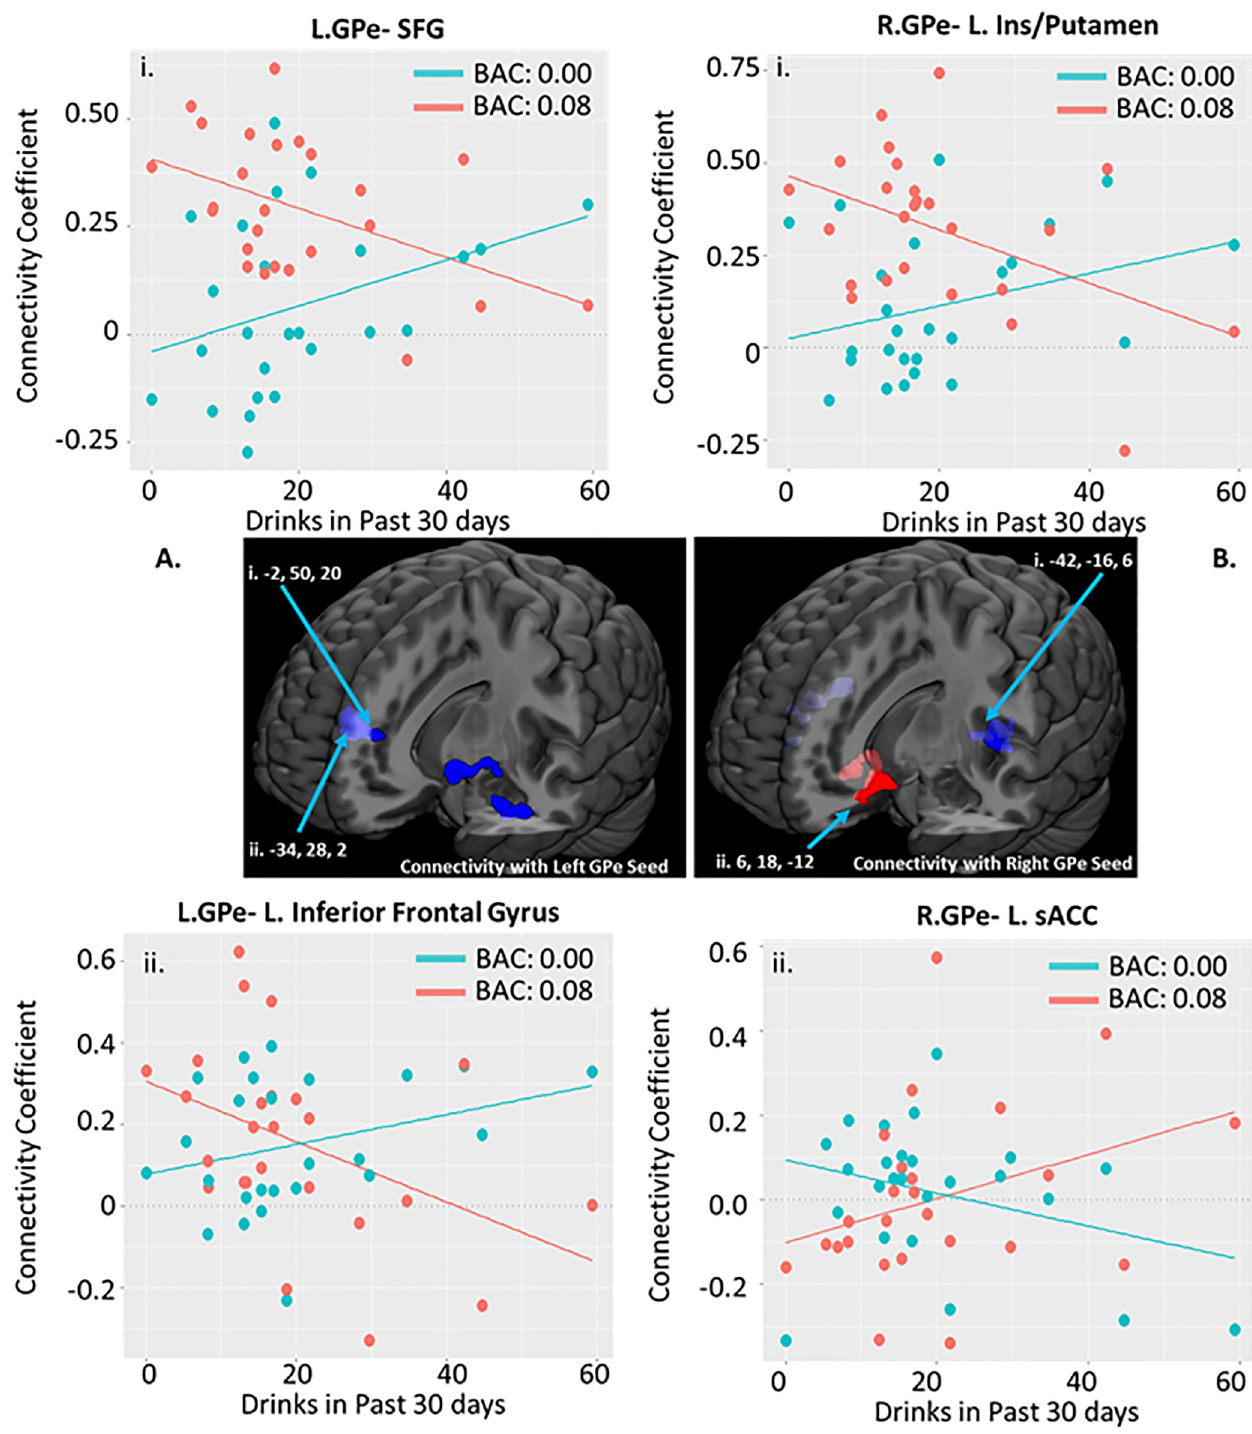
Fig 2. Association between past 30 day drinking and alcohol induced changes in GPe connectivity. (As measured by the Alcohol Timeline Followback). Scatter plots correspond to individual connectivity at baseline in teal (estimated BAC: 0.0) and after infusion in salmon (BAC: 0.08); linear fit lines are also displayed for each timepoint. Connectivity coefficient is the r (correlation value) between the signal in the GPe seed and the coordinate indicated. Brain images represent whole effects of drinks in past 30 days on alcohol induced change in functional connectivity (post-infusion connectivity > pre-infusion connectivity). Warm colors indicate intoxication related increases in connectivity; cool colors indicated intoxication related decreases in connectivity. Images shown at p < 0.005. Clusters with significant interaction effects are reported in Fig 3. Reported clusters of connectivity with GPe area correspond to the following regions: A.i.—Superior Frontal Gyrus extending into dorsal anterior cingulate; A.ii.—Hippocampus/amygdala; B.i.—Heschl’s Gyrus extending into the insula/putamen; B.ii.—Heschl’s Gyrus extending into the insula/putamen.